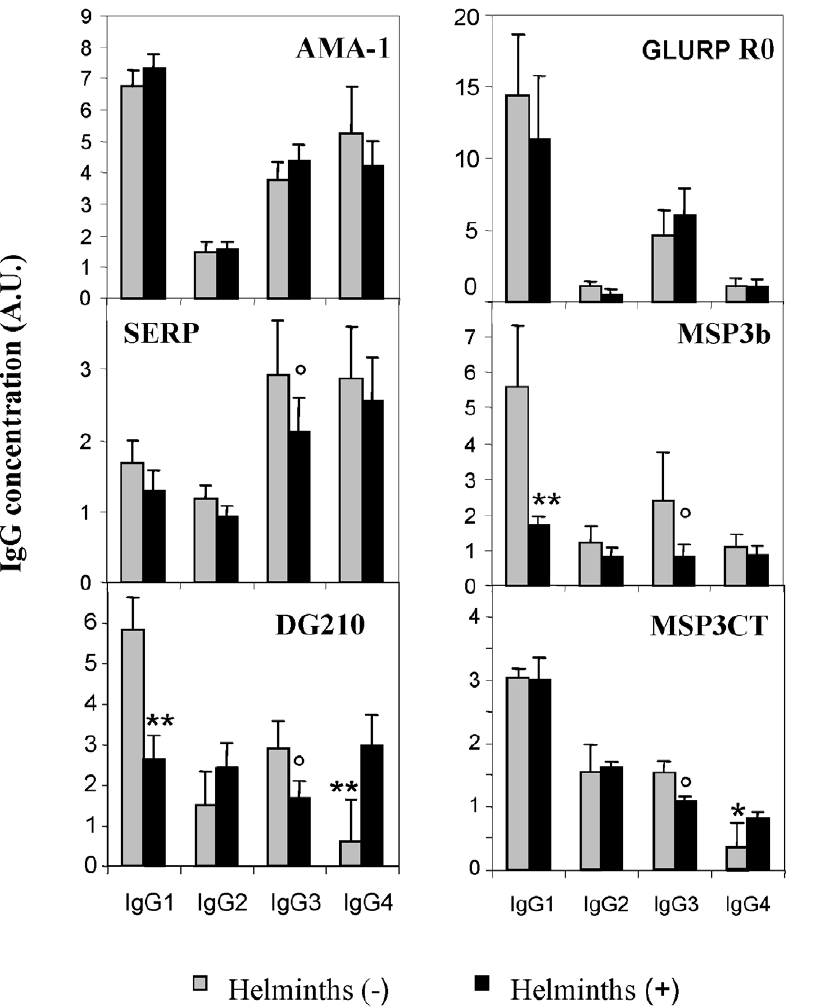
Figure 2. Anti-MSP3 cytophilic Antibody responses are significantly lower in worm-positive than in worm-free children. Mean reactivity and standard errors of the mean IgG A.U. obtained in ELISA assays with sera from children harbouring (helminths + ), or not (helminths 2 ) helminthic infection(s) using different antigens including AMA-1, SERP-SERA, GLURP-R0, MSP3b, DG210 and MSP3CT. Labels indicate when differences were found significant in univariate analysis: u when 0.06 . p $ 0.05, * when 0.05 , p $ 0.0021 and ** when p , 0.0021 (a p value of 0.0021 accounts for the multiplicity of tests carried out).